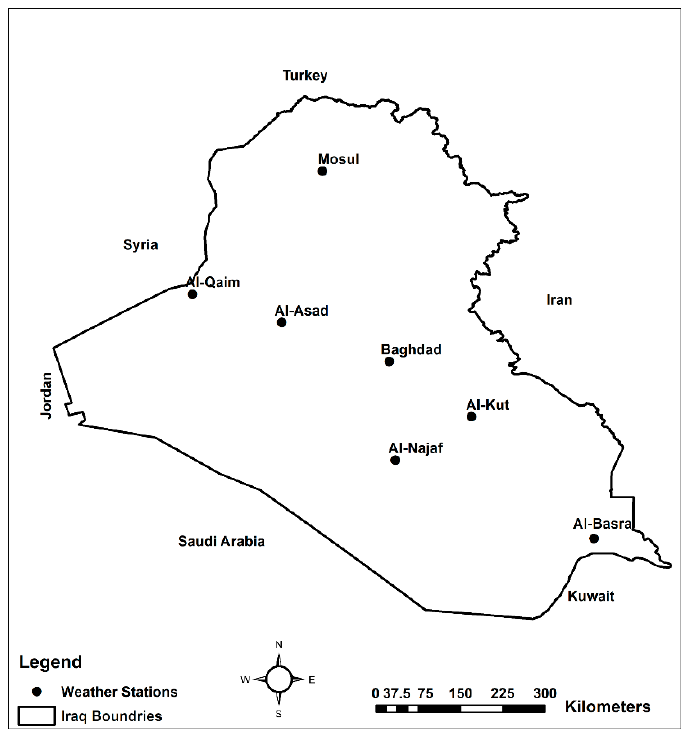
Figure 1. The location of weather stations in the study area.